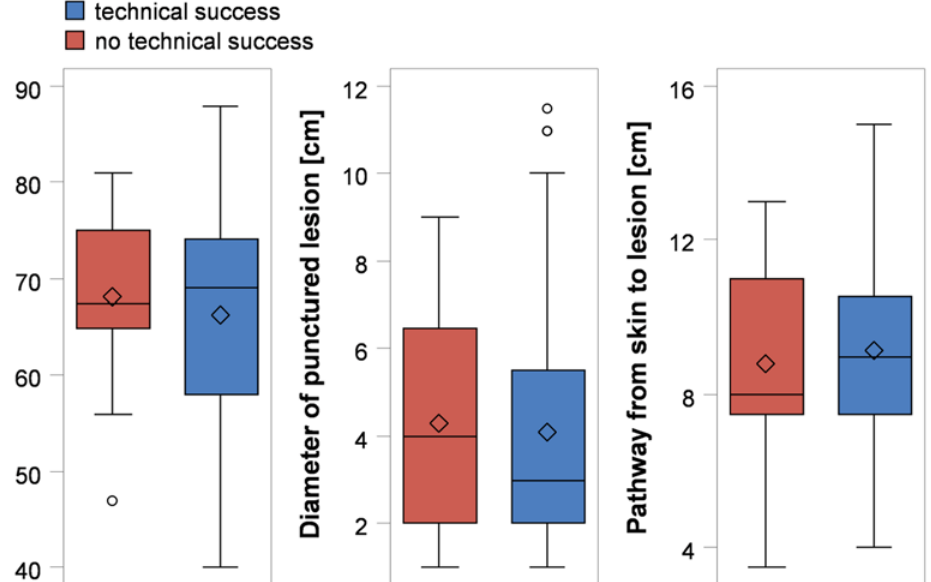
Fig 1. Technical success rates of CT-guided percutaneous transthoracic lung biopsies of pulmonary tumors according to patient age, lesion diameter, and length of interventional pathway.